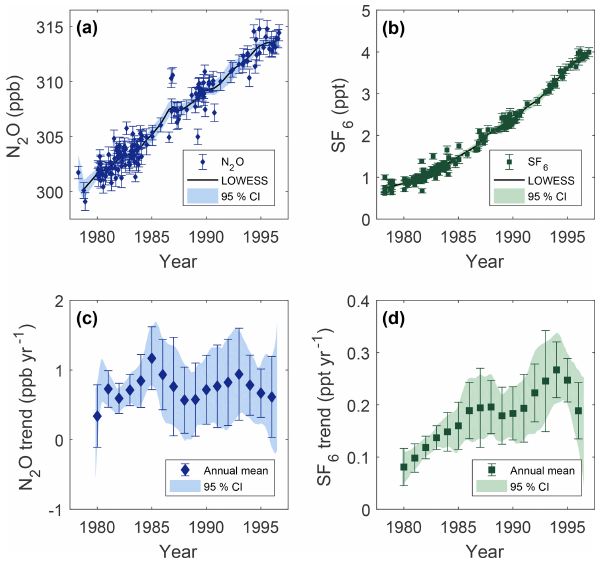
Figure 5. Deseasonalized measurements of mole fraction vs. date of collection for N 2 O (a) and SF 6 (b) , and annual trends in time from Cape Meares, Oregon, for N 2 O (c) SF 6 (d) . Error bars are 1 σ uncertainty. The solid black lines are LOWESS fit to the data using a smoothing window of 3 years, and shaded areas are 95% confidence intervals in the LOWESS fit calculated from bootstrapping residual variability 1000